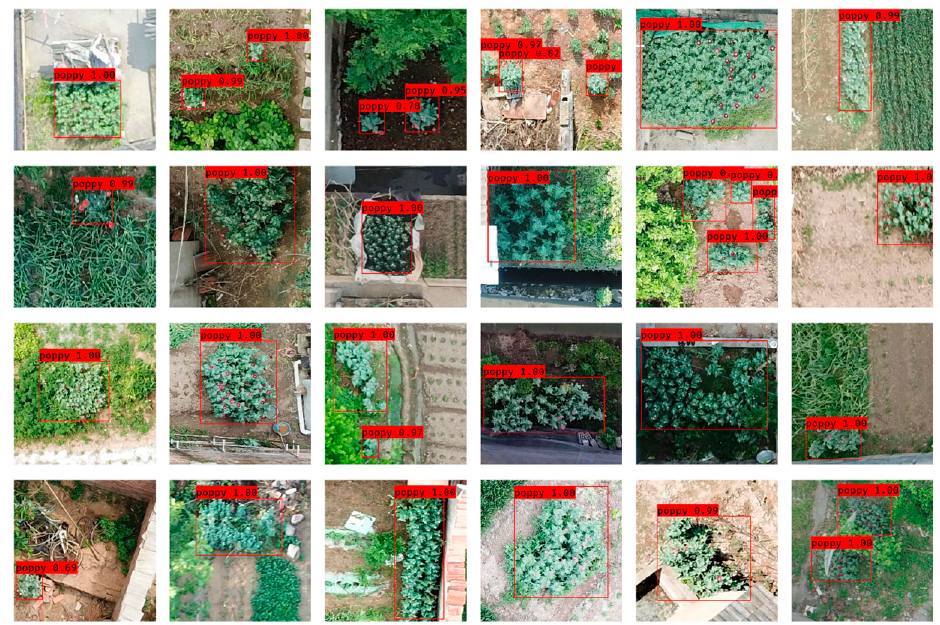
Figure 14. Partial detection results of the SPP-GIoU-YOLOv3-MN model using the testing dataset.